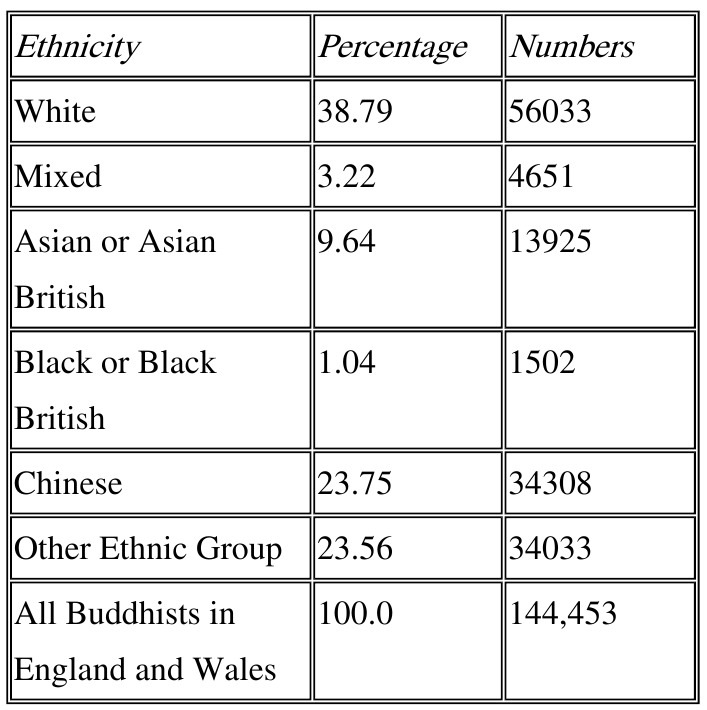
Table 1: Ethnicity of Buddhists in England and Wales